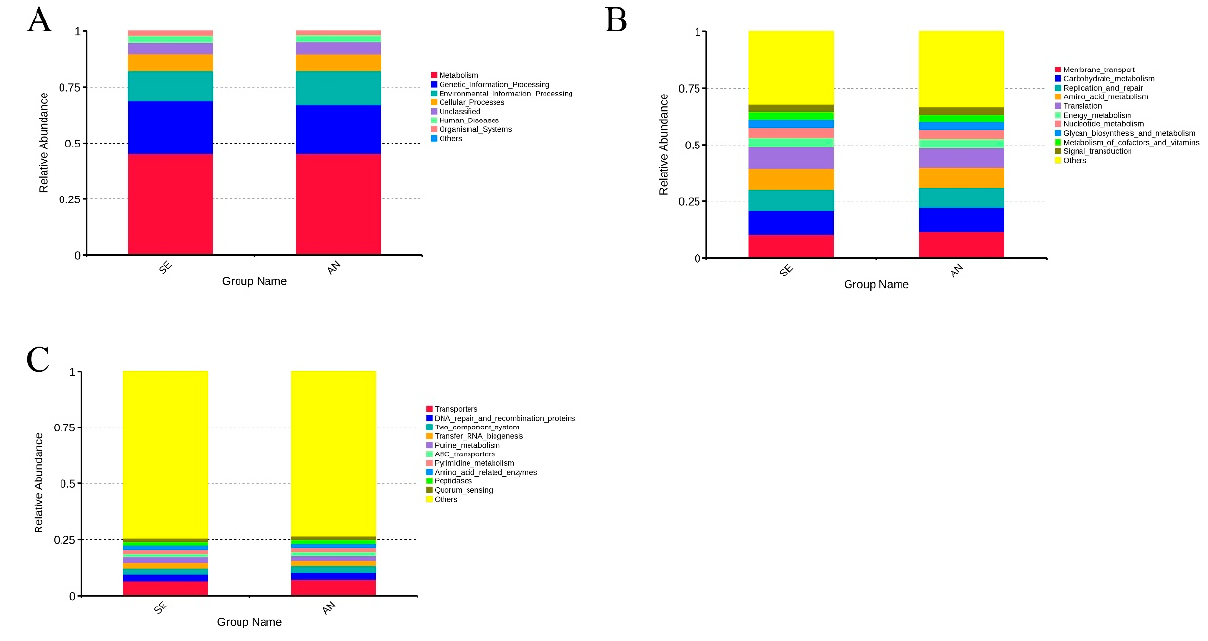
Figure 10. Top 10 enriched functional categories (KEGG level 1 ( A ), level 2 ( B ), and level 3 ( C )) of the bacterial communities in the AN and SE samples.